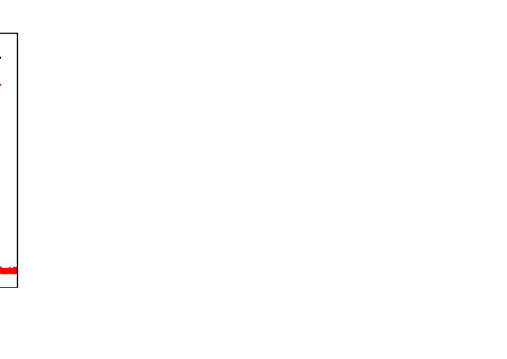
Figure 4. Waveforms of the accelerated beam recorded at the CT (black trace) and the FC (red trace) detector locations. These measurements were triggered by laser light detected by a photodetector when a laser-produced plasma was generated. The black curve shows a waveform measured at the CT attached to the exit of the RFQ linac. Because this detector picks up 100 MHz RF noise due to the proximity of the detector to the RFQ linac, a 98 MHz low pass FFT filter was applied to remove the resonant 100 MHz RF signal imposed on the detected signal. The red curve shows a waveform at the FC after the analyzing magnet guiding the 7 Li 3+ ion beam. At this magnetic field, N 6+ and O 7+ can be transported in addition to 7 Li 3+